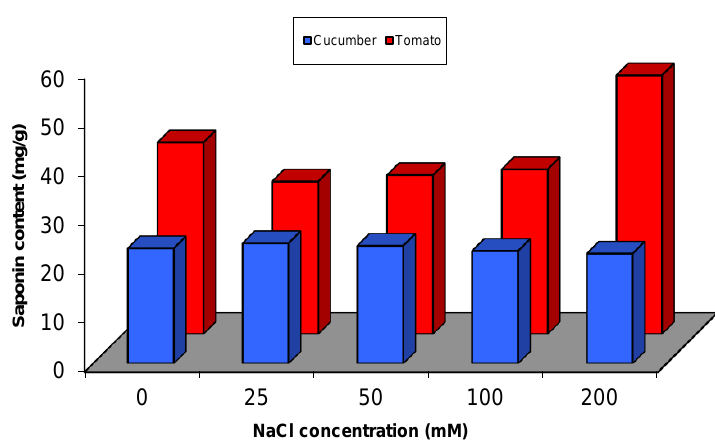
Figure 7. Saponin content in cucumber and tomato under NaCl stress.